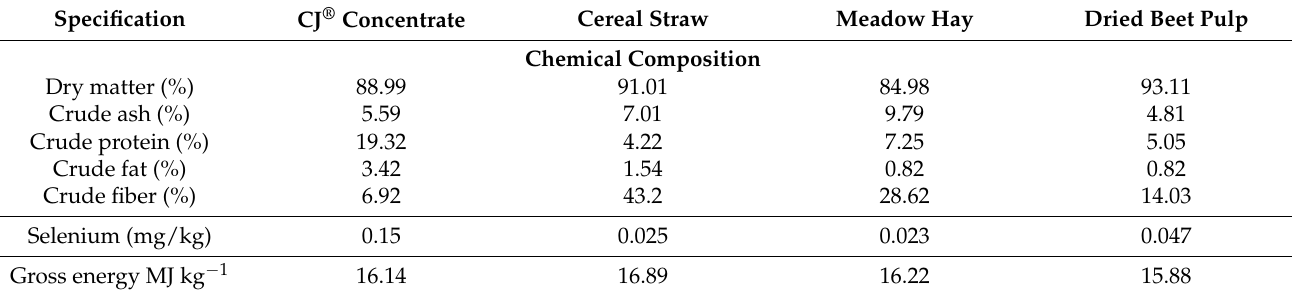
Table 1. Chemical composition of dams diets (% of fresh